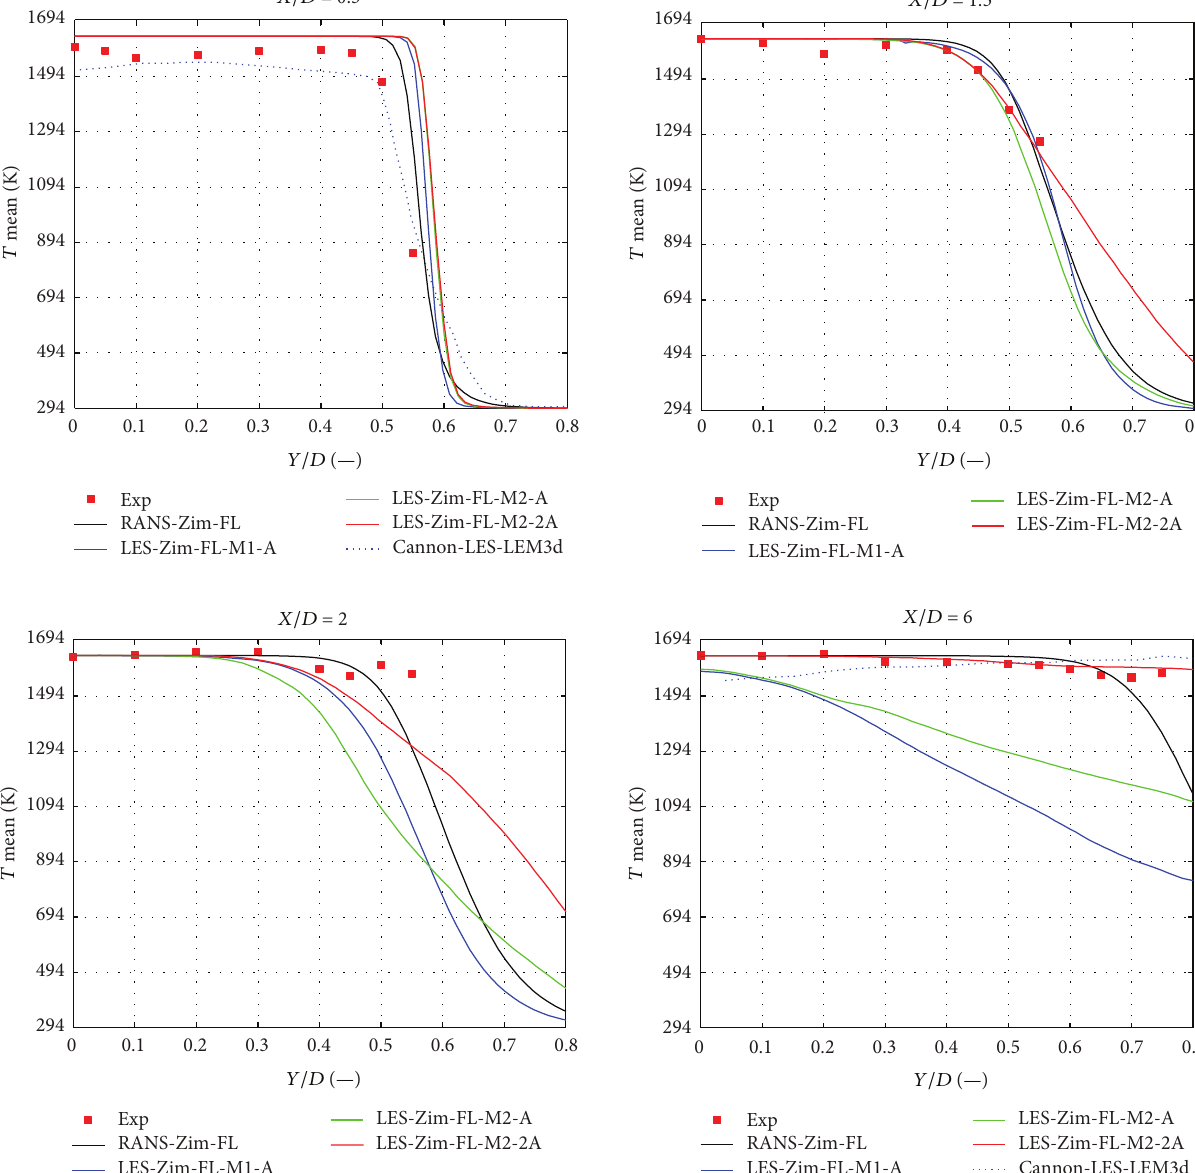
Figure 9: Mean temperature profiles at different axial